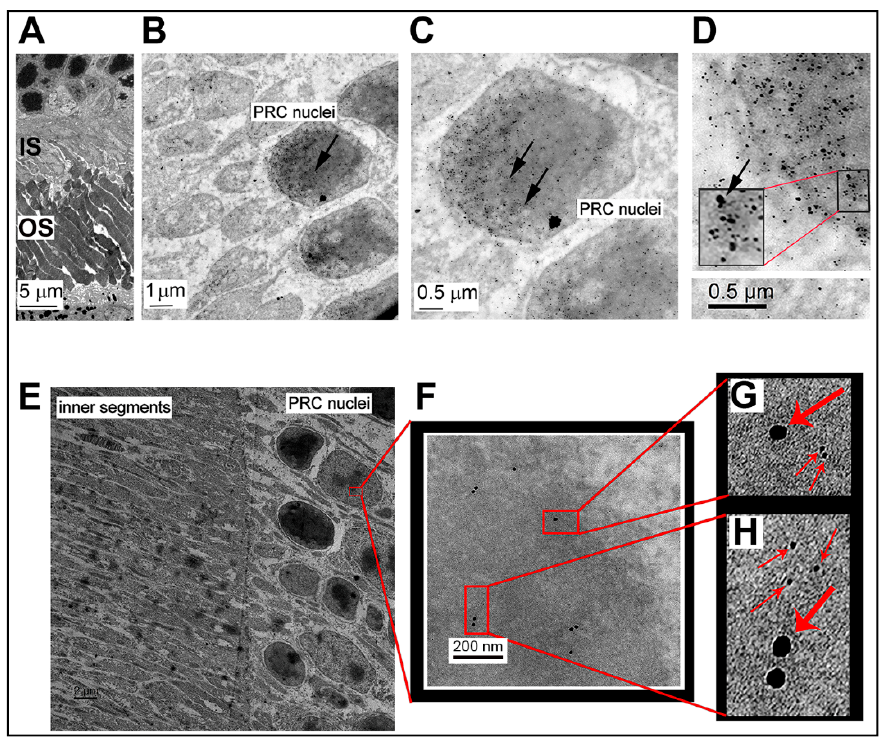
Figure 4. EM immunodetection of Sig1R and NRF2 in photoreceptor cells of WT mouse retinas. WT mouse retinas were processed for post-embedding EM immunolocalization to detect Sig1R and NRF2 using nanogold- ( A – D ) or colloidal-gold-labeled ( E – H ) secondary antibodies. ( A ) Low- magnification image of the outer portion of the retina, specifically the inner segments and adjacent photoreceptor cell nuclei. Increasingly higher magnifications are shown in ( B – D ). The nanogold labeling of larger and smaller particles reflects NRF2 and Sig1R, respectively, as explained in the methods section. ( D ) The clusters of large and small particles demonstrate an abundance of co- localization between Sig1R and NRF2 in the photoreceptor cell nuclei. Data from colloidal gold labeling confirm the nanogold labeling. ( E ) Low-magnification image of photoreceptor cell nuclei and adjacent inner segments. ( F ) Higher magnification of a single photoreceptor cell nucleus with colloidal gold particles evident. ( G , H )Higher magnification insets from (F) show the close proximity (<50 nm) of the two differently sized gold particles, confirming the close proximity of Sig1R (18 nm) and NRF2 (6 nm) in the photoreceptor cell. Abbreviations: IS = inner segments; OS = outer segments; PRC = photoreceptor